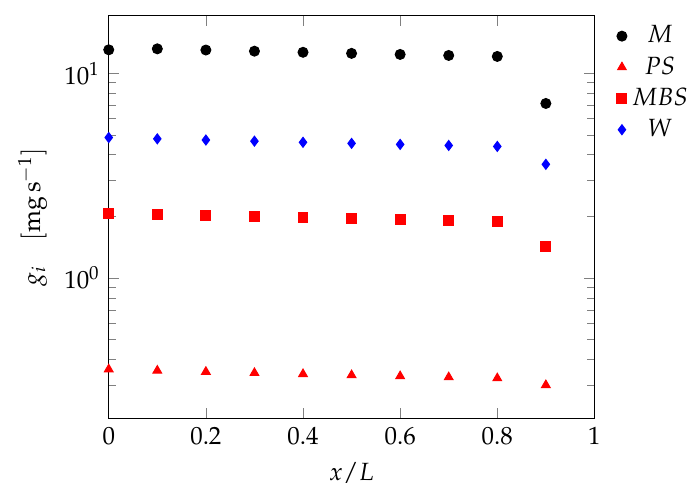
Figure 9. Intermediate species feedrates positioned along the dimensionless axial coordinate of a series of N d = 10 PFRs as computed from the recipe of test